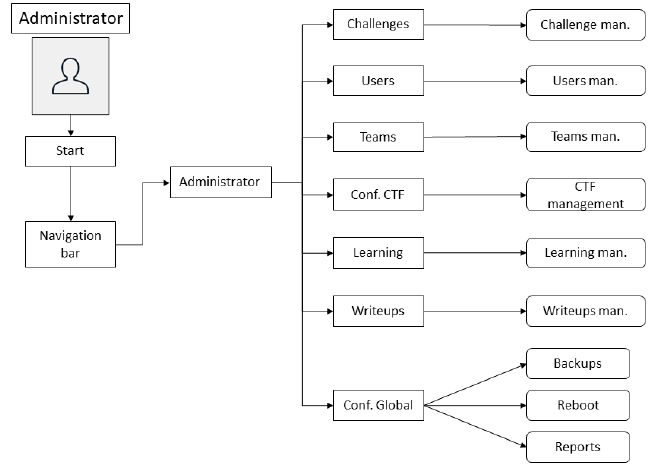
Figure 3. Block diagram of the administrator role.